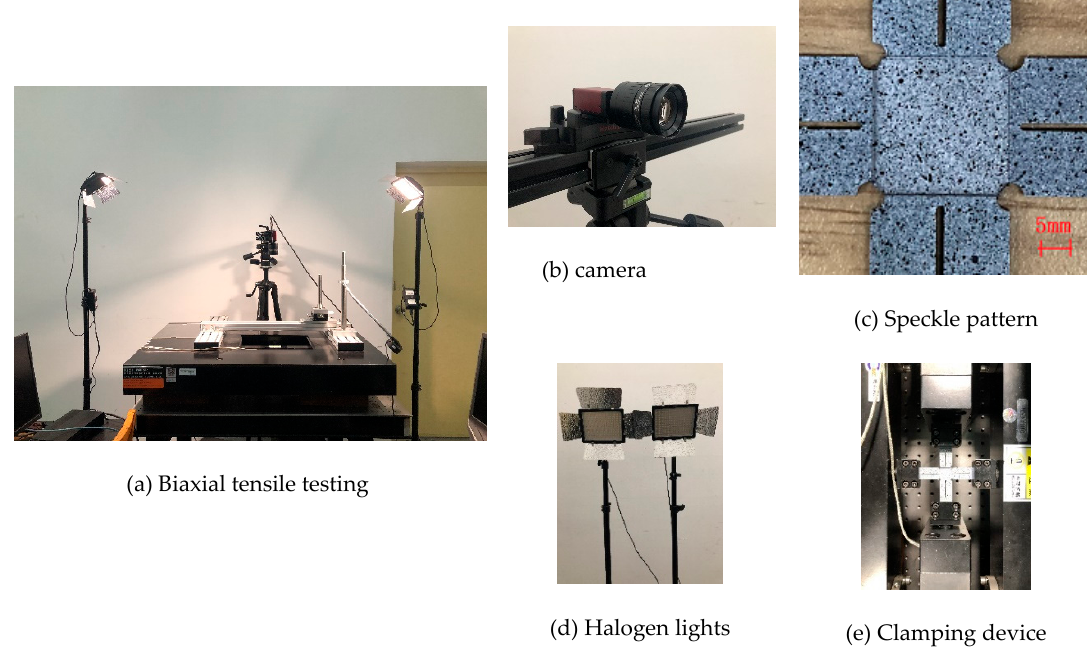
Figure 14. DIC system for biaxial tensile testing.